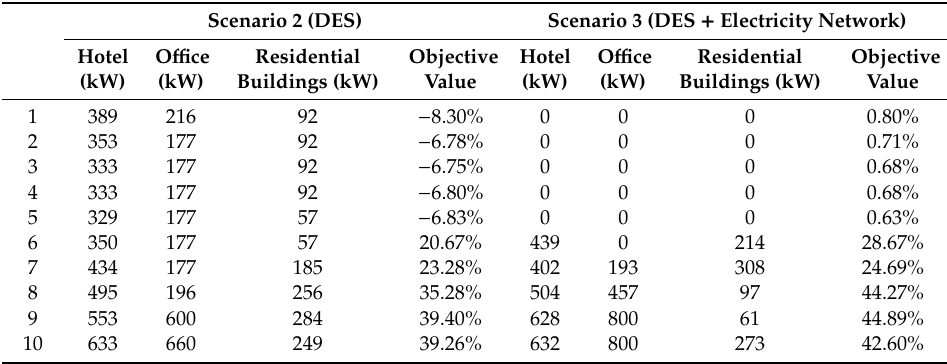
Table 8. The results of optimal system design of hourly energy demand in typical summer